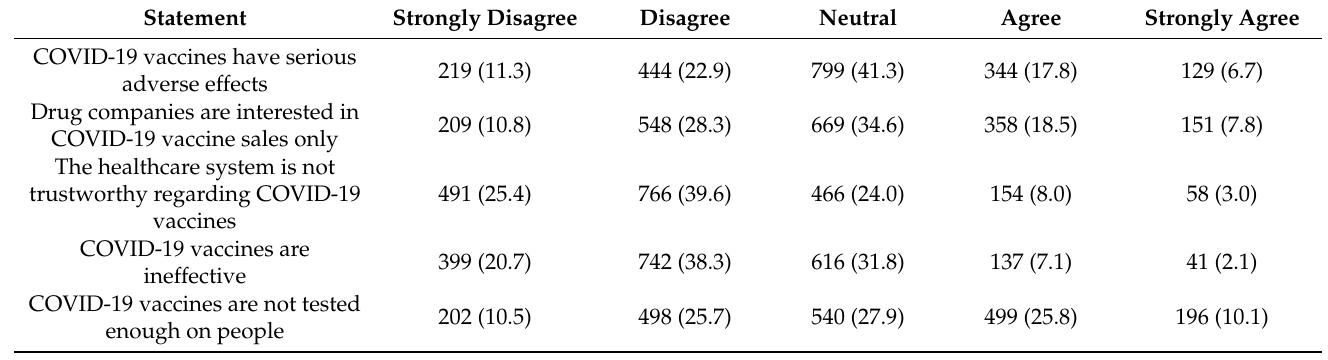
Table 3. Concerns of participants about COVID-19 vaccines.